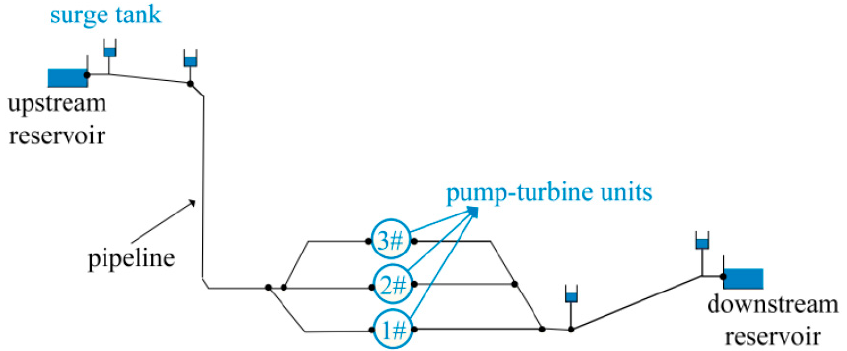
Figure 4. The diagram of the hydraulic system.